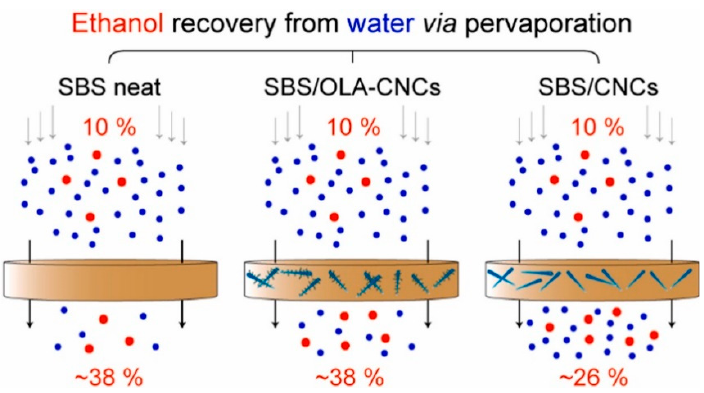
Figure 18. Performance of SBS/CNC and SBS/OLA-CNC nanocomposite membrane for ethanol separation.